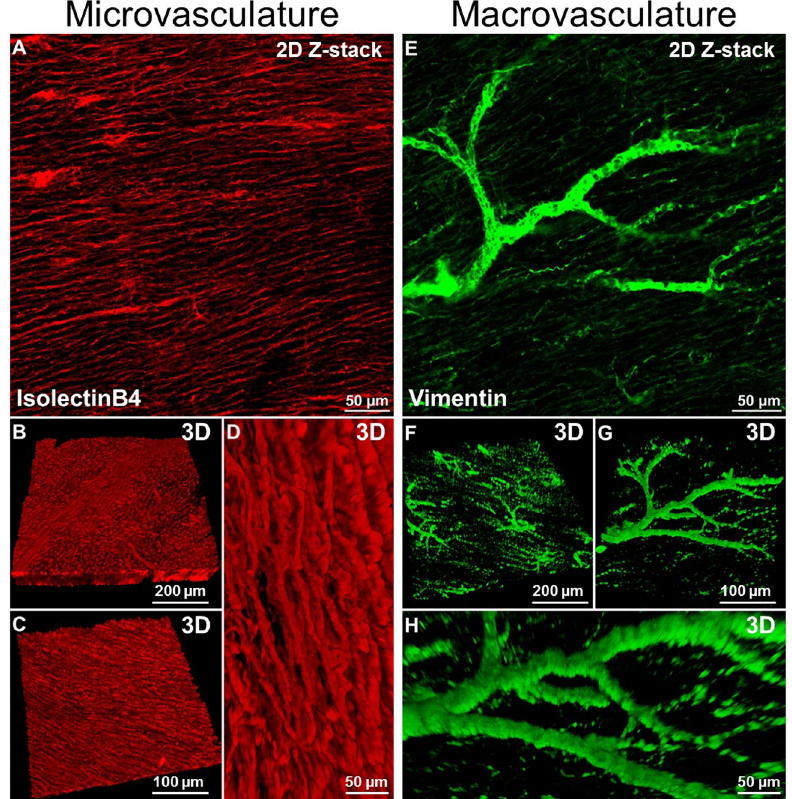
Figure 4. Immunostaining and imaging of micro and macrovasculature in cardiac tissue. ( A ) Two dimensional image of capillaries labelled with IsolectinB4. ( B – D ) Three dimensional reconstruction of myocardial tissue microvasculature at different magnifications. ( E ) Two dimensional image of larger vessels labelled with Vimentin. ( F – H ) Three dimensional reconstruction of myocardial tissue macrovascular network at different magnifications. At least 3 slices were used for each